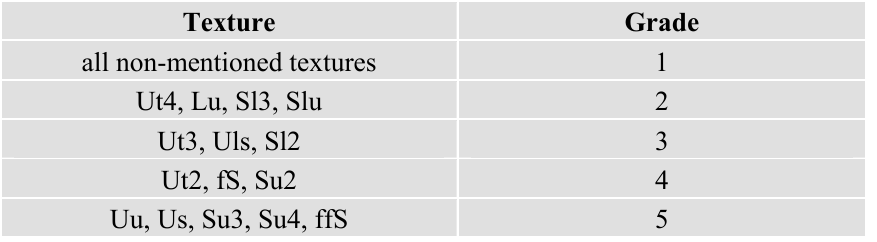
Table 5. Assessment of the sensitivity grade towards slaking according to the texture of